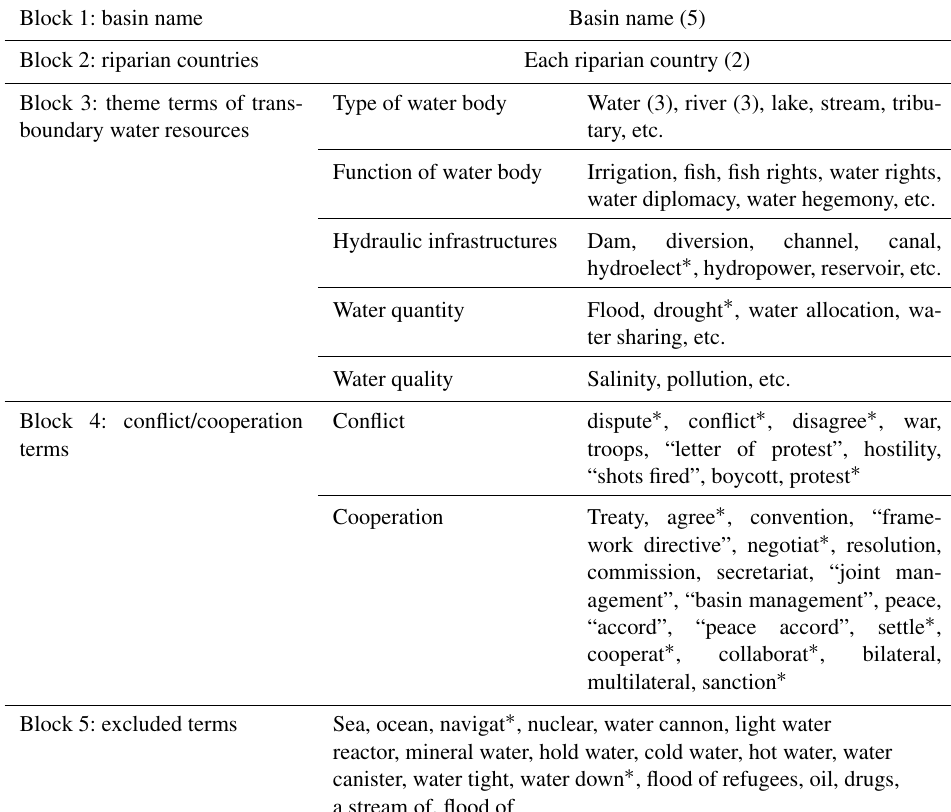
Table 2. Example of keywords in Blocks 1–5.